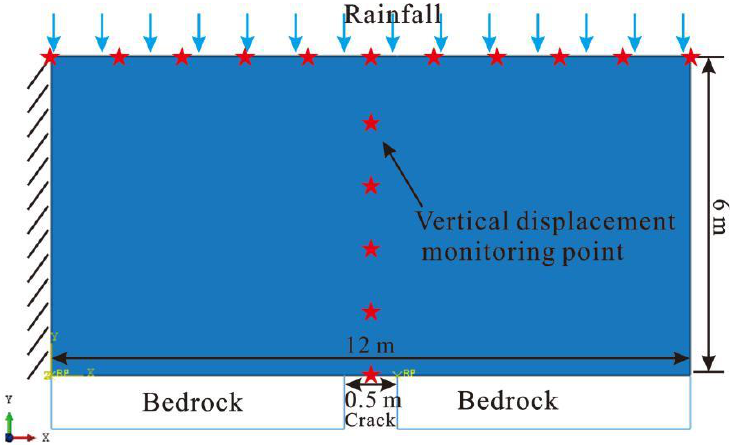
Figure 5. Visualization of the numerical calculation model.